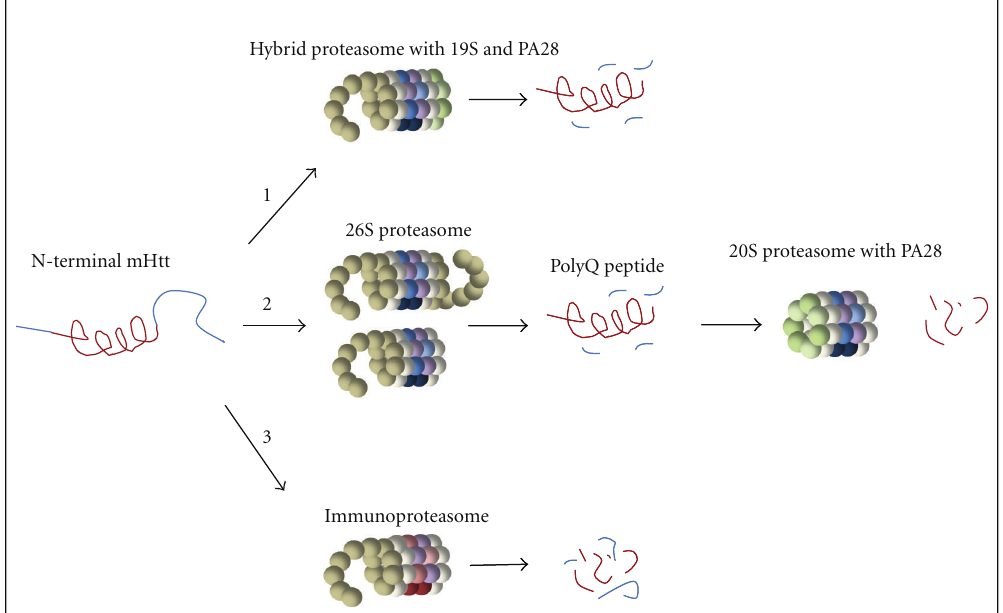
Figure 3: Potential proteasomal pathways for polyQ degradation. (1). Hybrid-proteasomes can recognize ubiquitinated proteins by the 19S cap and release the polyQ peptides faster due to an open gate conformation facilitated by PA28. (2) 26S proteasomes may be able to degrade mhtt but not the actual polyQ tracts. The released polyQ peptide could be targeted by PA28-capped proteasomes. (3) Changing the catalytic activity by immuno-subunit replacement might improve degradation preference for polyQ